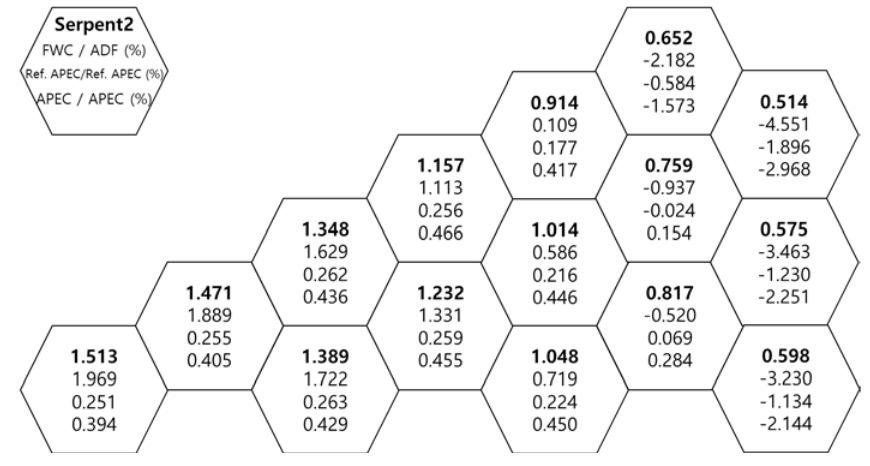
Figure 4. Radial Power Distribution of sPGSFR and Relative Power Error.